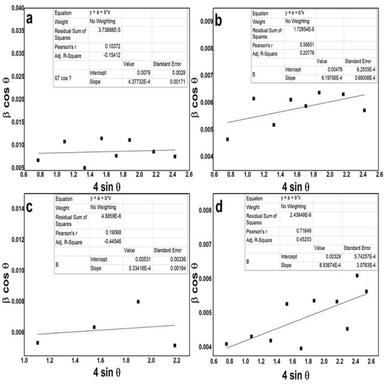
WH plot of prepared samples a) Pristine BTO, b) 1% Fe doped BTO, c)2% Fe doped BTO & d)3% Fe doped BTO.